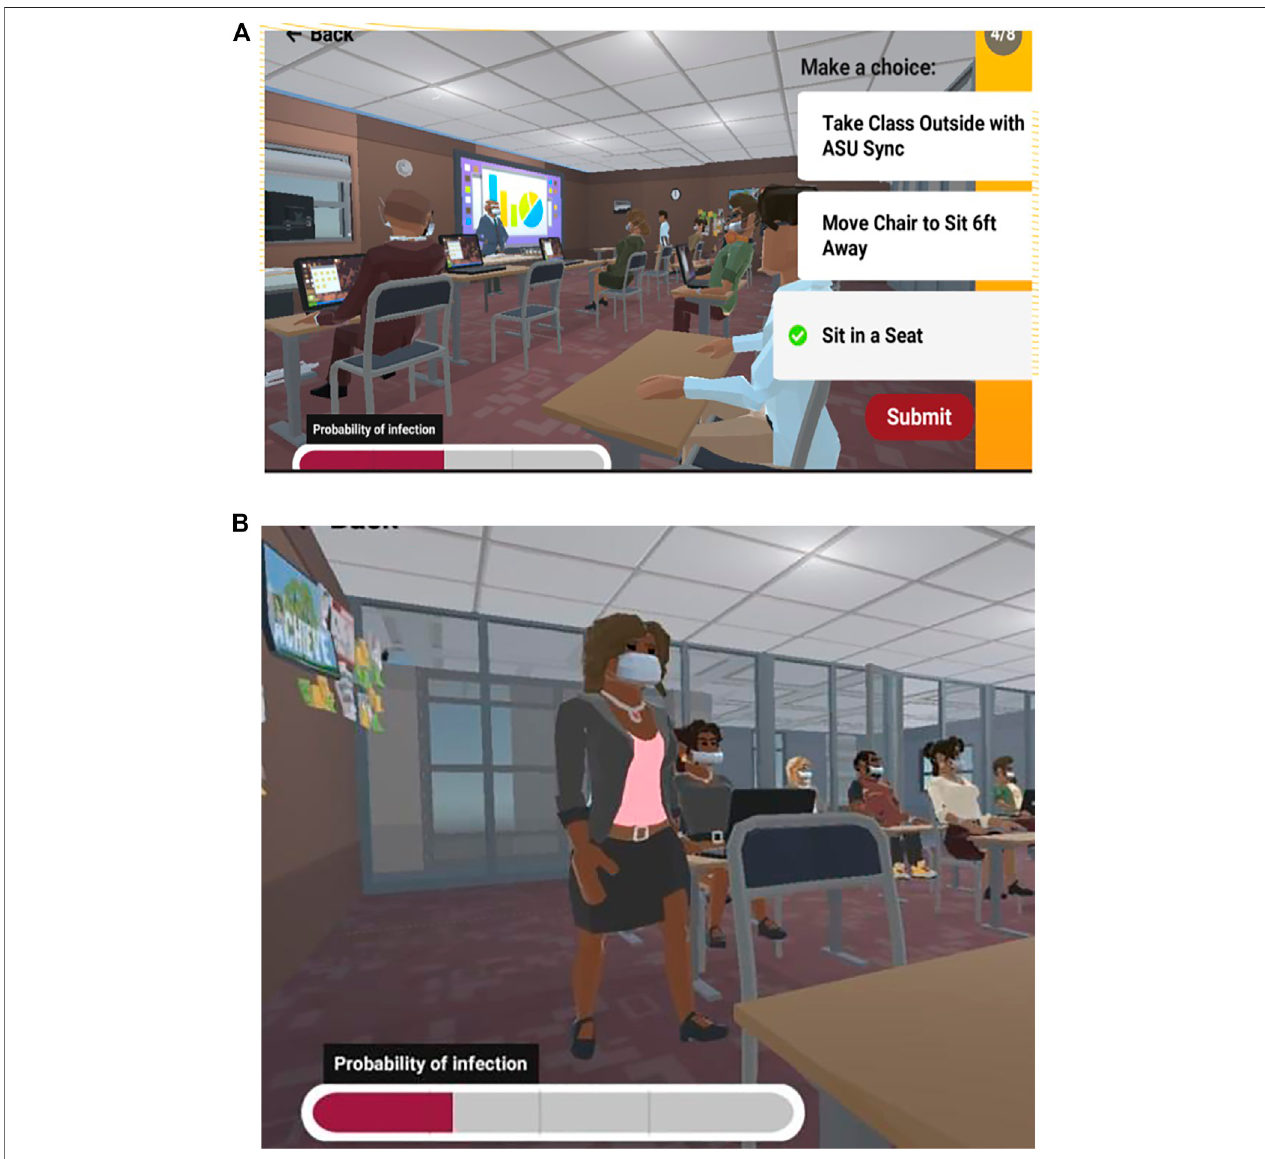
FIGURE 5 | Panel A text for choice and full image, panel B shows the action taken with probability